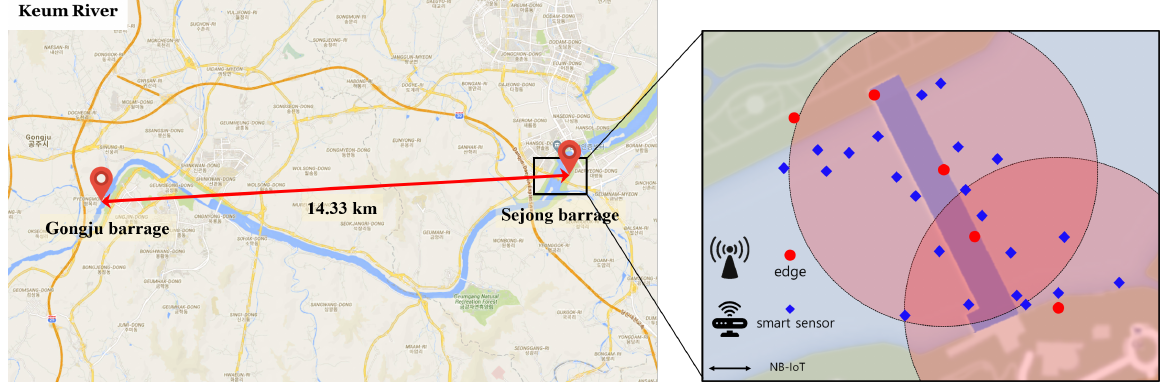
Figure 2. Overall network architecture: This shows Gongju barrage and Sejong barrage in the Keum River, where the actual green tide is found in Korea are considered in this paper. Several edges and smart sensors are distributed around one barrage and are designed to communicate through NB-IoT. The red dot shown in the figure is edge located on the barrage and the blue diamond is smart sensor that measures water quality in the river.